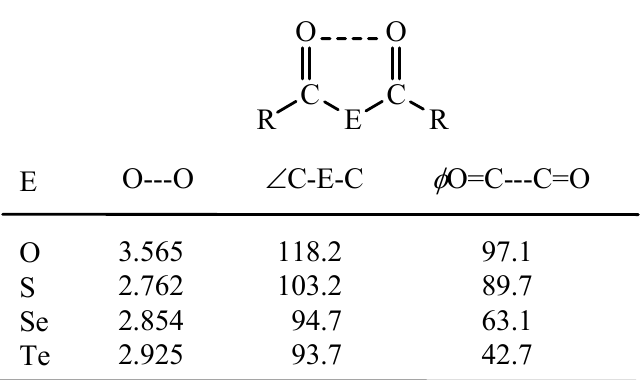
H CO) Te ( 7 ) calculated at the 6 4 2